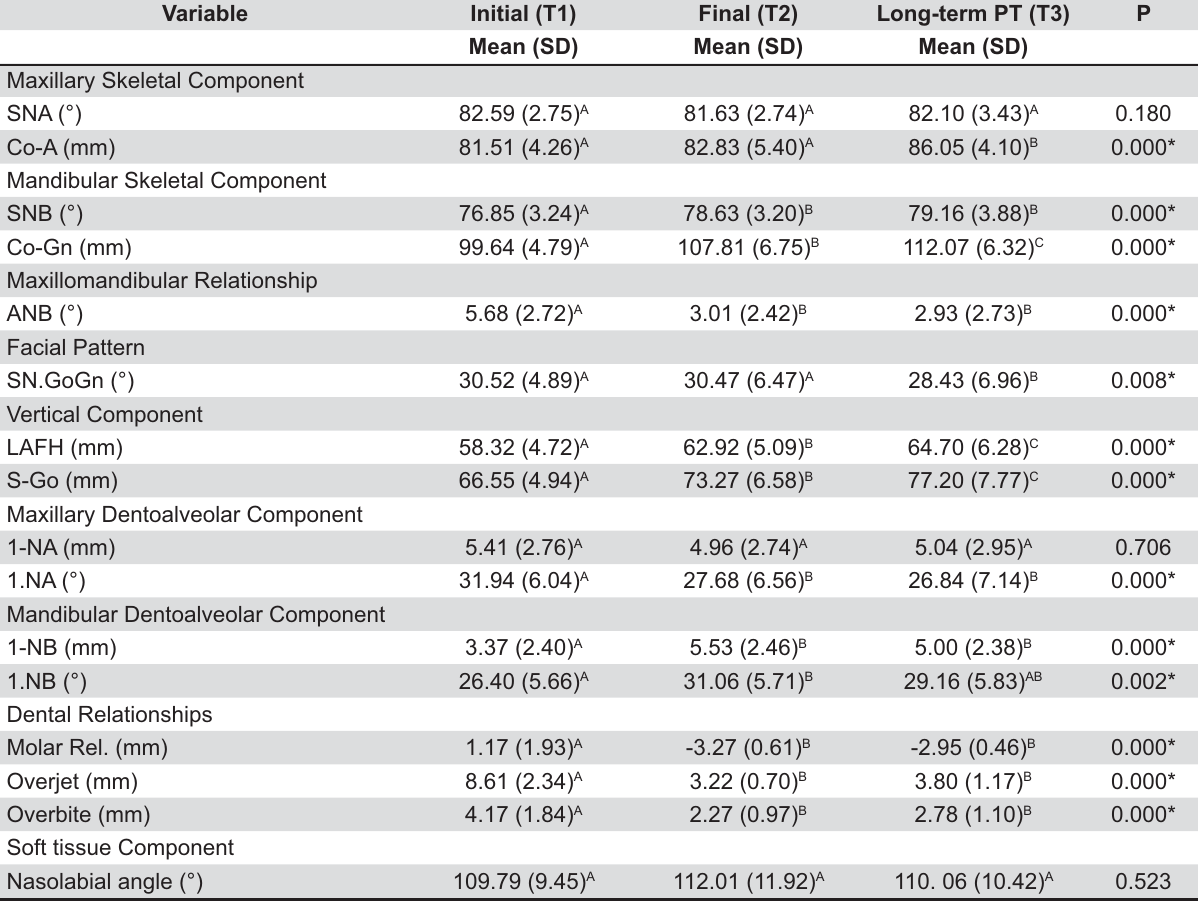
Table 2- Comparison of the cephalometric variables at the three stages (repeated measures ANOVA followed by Tukey